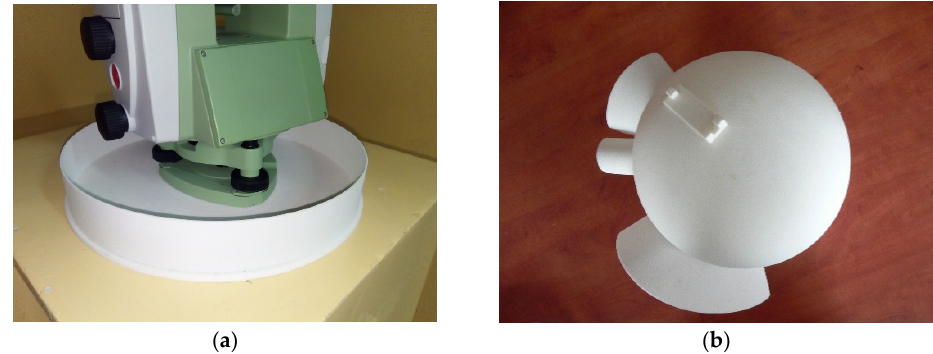
Figure 6. View of the protective housing’s elements: ( a ) the profiled pad placed beneath the instru- ment’s tribrach, ( b ) unique front and rear aiming sights enabling the